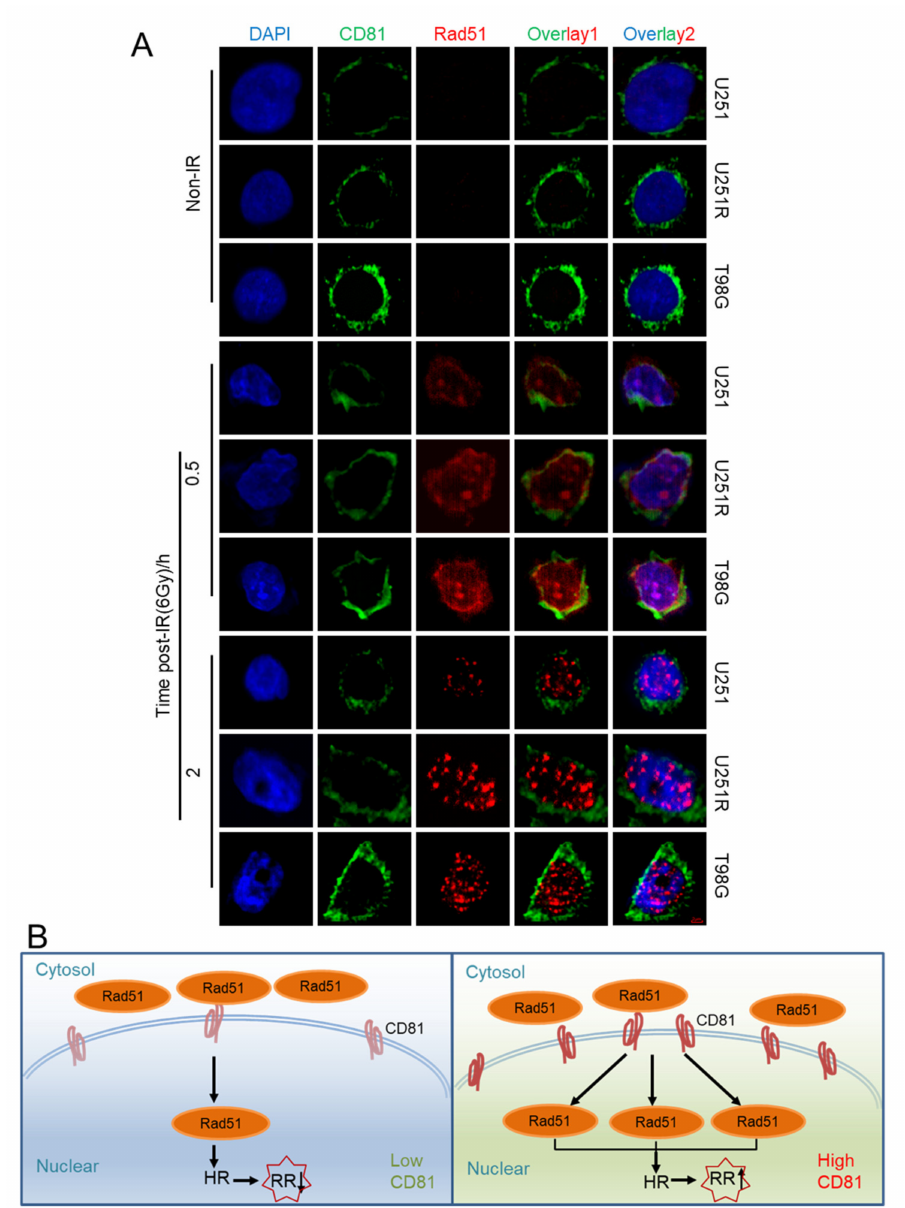
Figure 7. Nuclear membrane protein CD81 promoted nuclear transport of Rad51. ( A ) Immunofluo- rescence images of CD81 and Rad51 distribution in U251, U251R, and T98G cells at 0.5 and 2 h after 6 Gy irradiation. Blue, DAPI stained nuclear. Green, CD81 expression. Red, Rad51 foci. Overlay 1 represents the merged images of CD81 and Rad51 fluorescence, overlay 2 represents the merged images of overlay 1 and DAPI. ( B ) The diagrammatic sketches of the relationship between the level of nuclear membrane protein CD81 and nuclear translocation of Rad51 in GBM cells. High level of CD81 promotes the entry of Rad51 to nuclear, thus enhances homologous recombination repair ability and consequently raises tumor